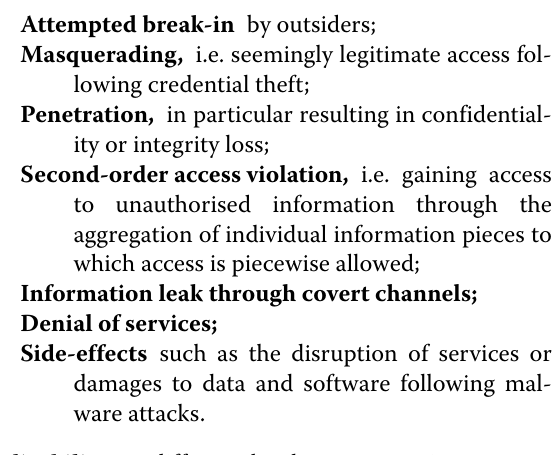
enable the identification of indirect relations between attributes. Finally, signatures are derived from the taint graphs and stored for further analysis or exploitation in later investigations. The signature format used by the authors is the Event Description Language (EDL) language. Figure 10 shows an example of a graph signature in the EDL language